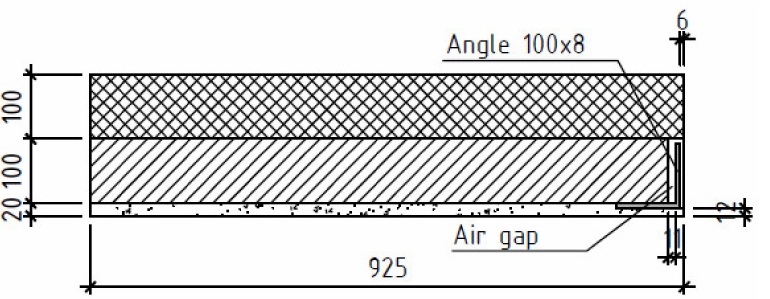
Figure 22. Calculation scheme without a gusset plate (units: mm). Thermal insulation—mineral wool with a density of 200 kg/m 3 and a thickness of 100